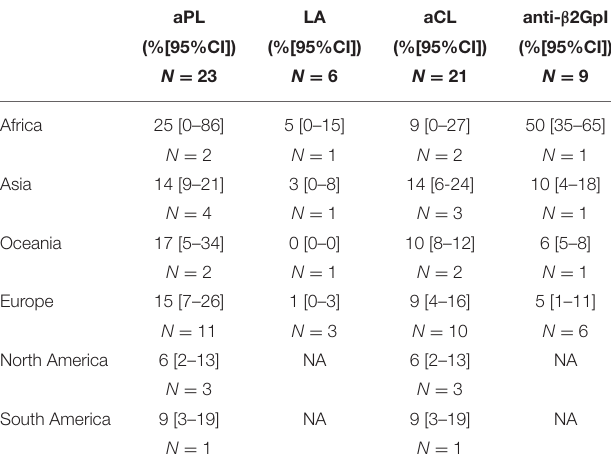
TABLE 6 | Results of meta-regression analyses of the associations between aPL prevalence and characteristics of the studies included. Variable